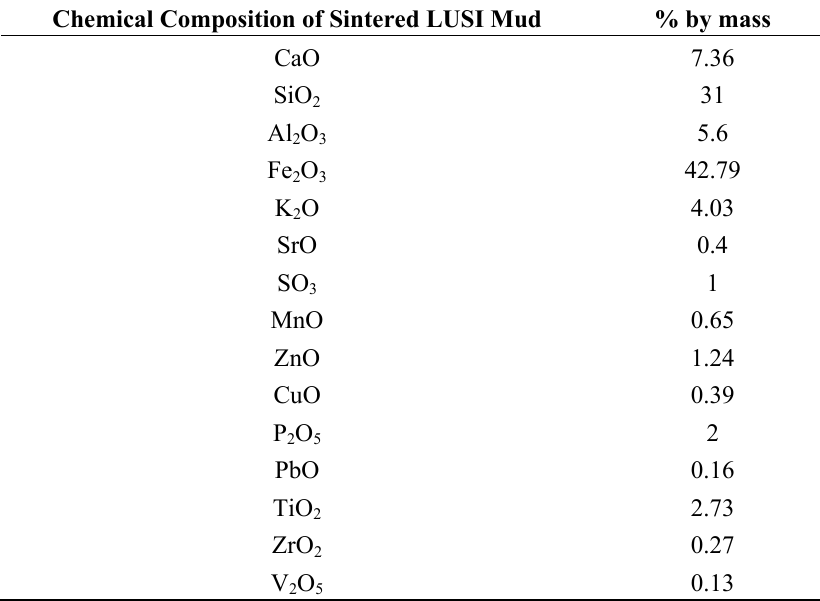
Table 1. Chemical composition of sintered LUSI mud as measured by XRF (% by mass).